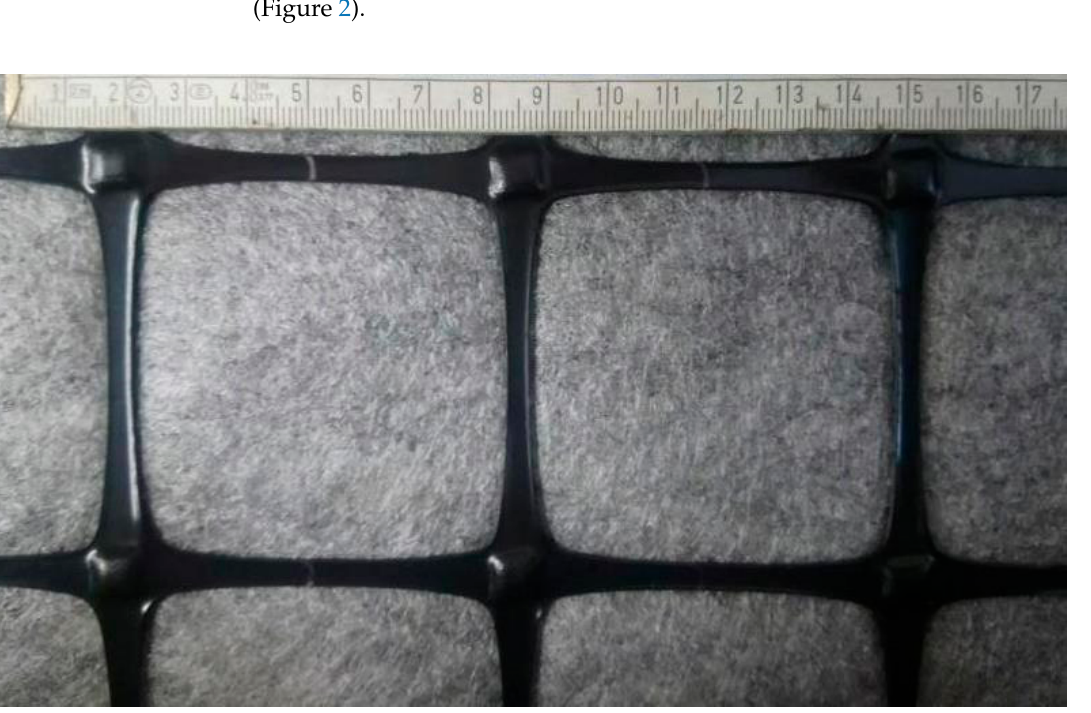
Figure 1. View of the AR-GN composite, square geogrid bonded to non-woven geotextile.